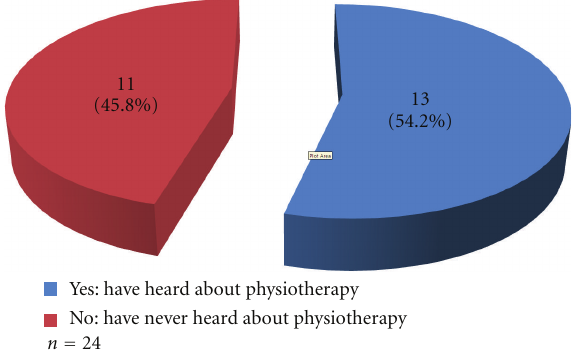
Figure 4: Knowledge of physiotherapy by health